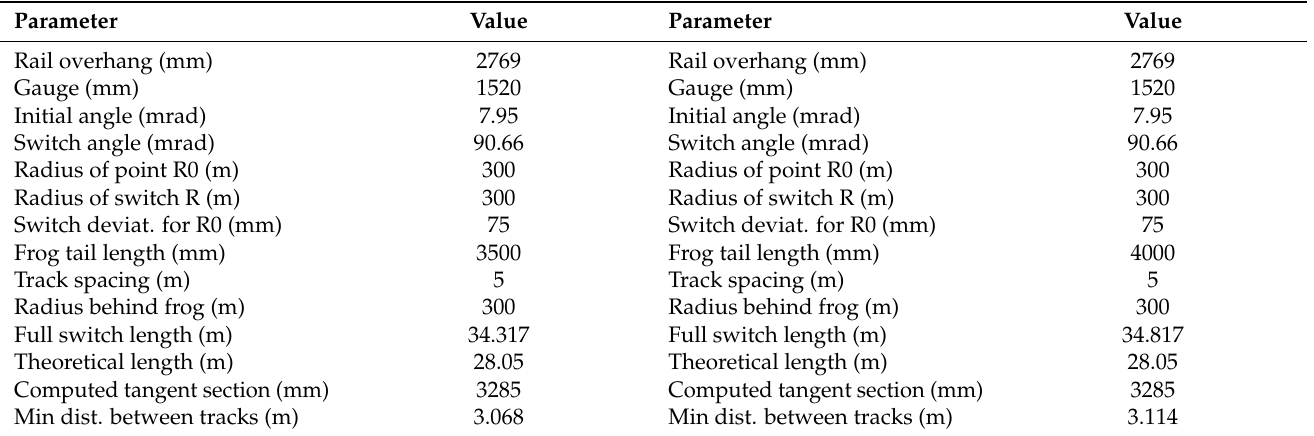
Table 5. Parameters of the proposed turnout in the